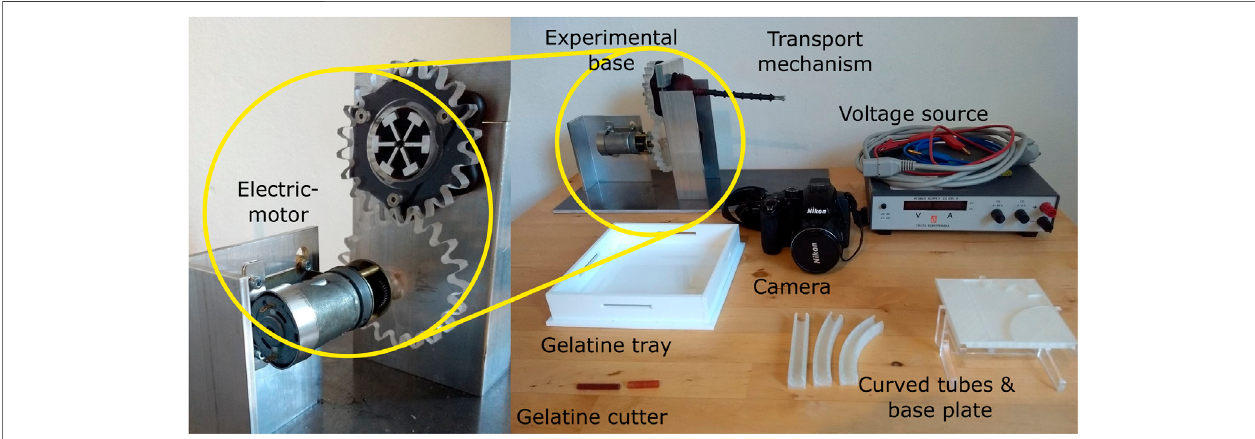
FIGURE10| Experimental facility.Theexperimentalfacilityconsistedofanelectromotorconnectedtoavoltagesourceandthehandleofthetransportmechanism throughagearmechanism,thetransportmechanismsplacedinsideanaluminiumframe,acameratorecordtheexperiments,abasedplatecontaining3D-printedtubes for the shaft curvature experiment, and a gelatine tray with cutter for the manufacturing of the tissue phantoms.